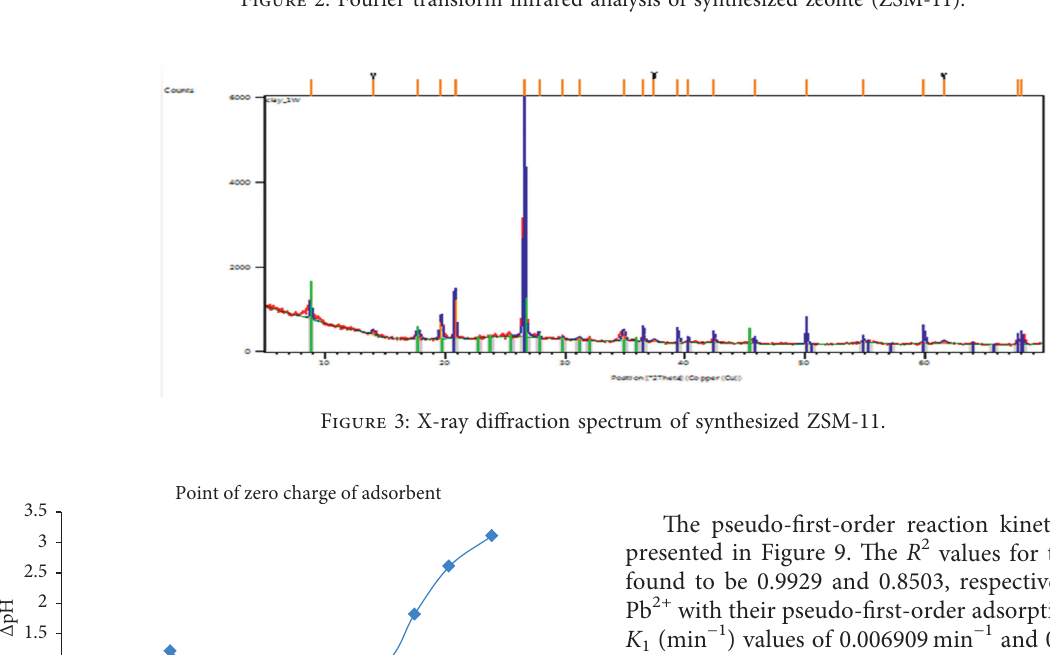
Figure 2: Fourier transform infrared analysis of synthesized zeolite (ZSM-11).